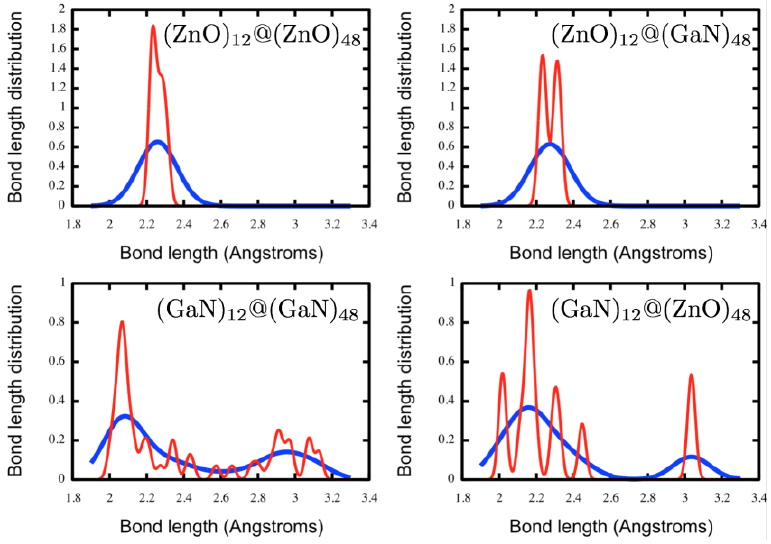
Figure 6. Bond distribution plots for the double bubble frameworks. Red line: Dispersion of Gaussian = 0.02, Blue line: Dispersion of Gaussian = 0.1.